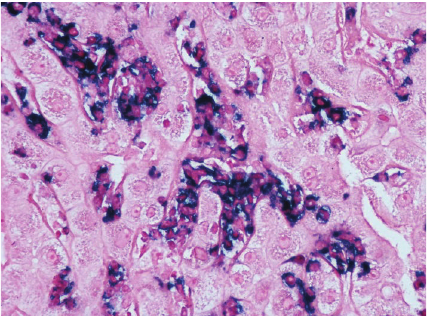
Figure 2: Kappa light chain restriction of the intrasinusoidal plasma cells.